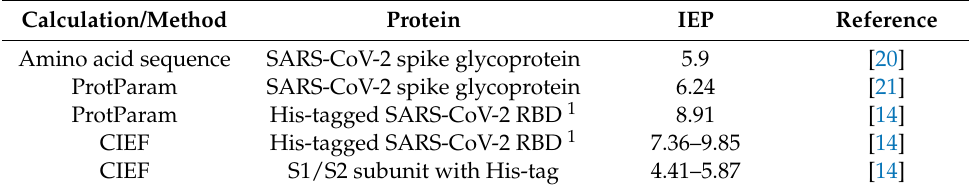
Table 1. Summary of current IEP values for SARS-CoV-2 S protein.